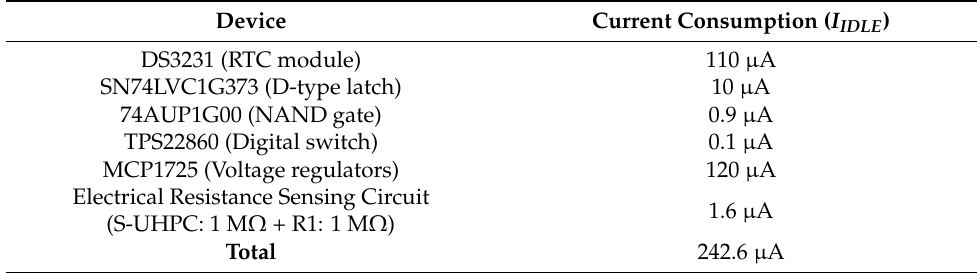
Table 1. Power consumption in Deep Sleep mode.